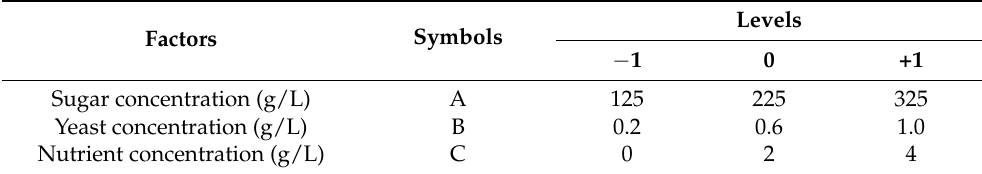
Table 2. Experimental factors and their associated levels used during the development of the